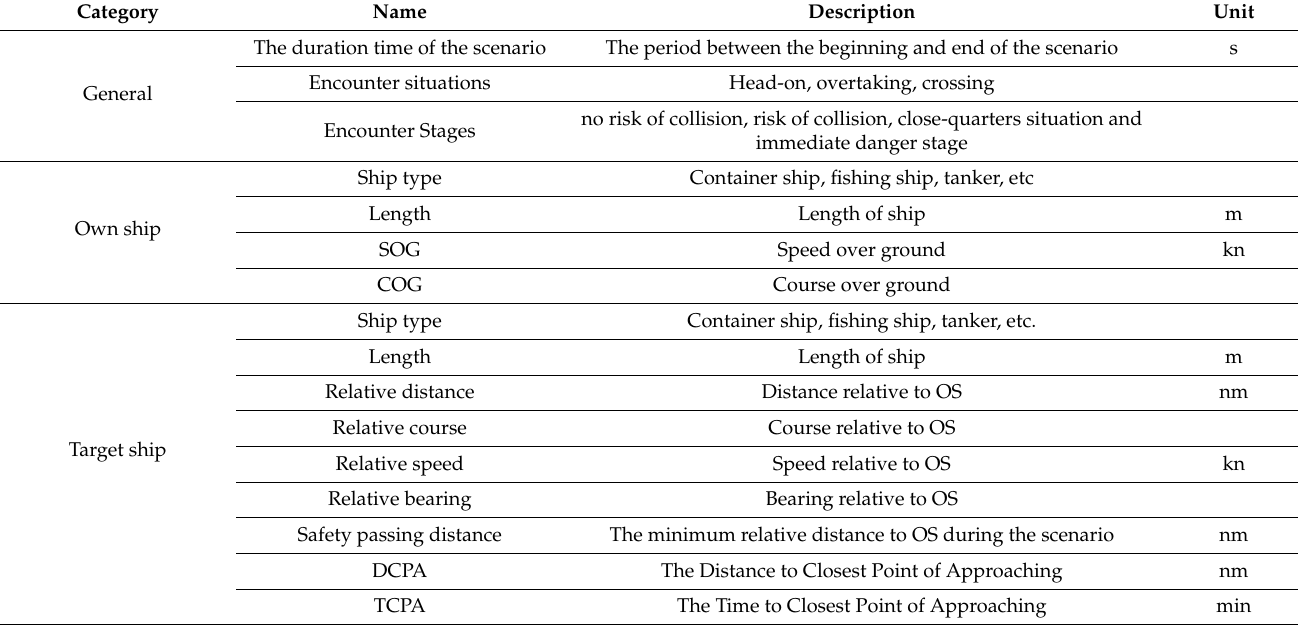
Table 1. Test scenario parameters.